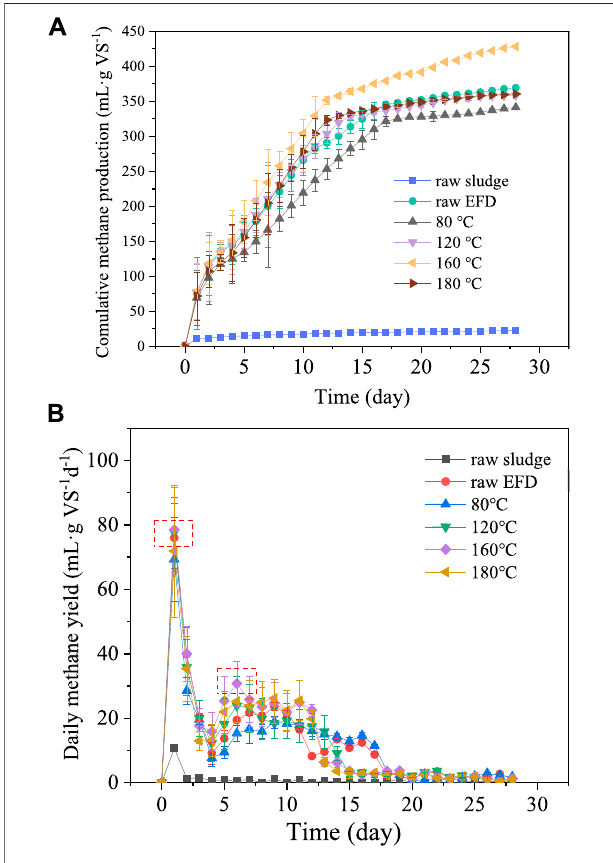
FIGURE 2 | Cumulative methane production (A) and daily methane production (B) of the erythromycin fermentation dregs (EFD) with hydrothermal treatment at different